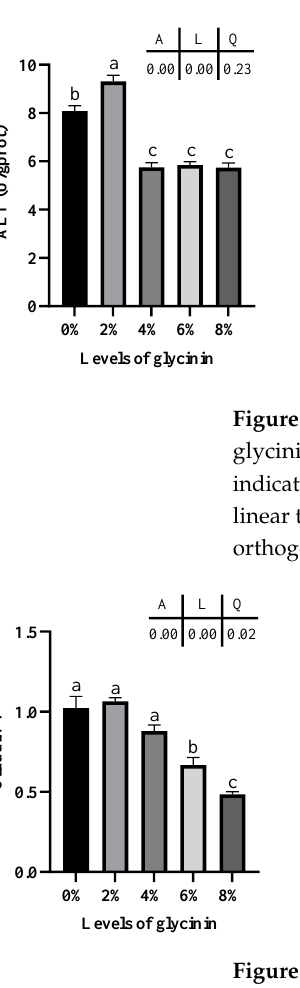
b ac Figure 4. The antioxidant and nonspecific immune enzyme activity in posterior intestine of hybrid yellow catfish fed with different glycinin levels. Data describe mean ± SE (n = 3). Obvious difference of means between groups is indicated by a, b, c and d ( p < 0.05). A represent the variance analyzed by one-way ANOVA; L represent linear trend analyzed by orthogonal polynomial contrasts; Q rep- resent quadratic trend analyzed by orthogonal polynomial contrasts. 2.5. Protein metabolic Enzyme Activity of Liver Protein metabolism enzyme activities in the liver of juvenile hybrid yellow catfish